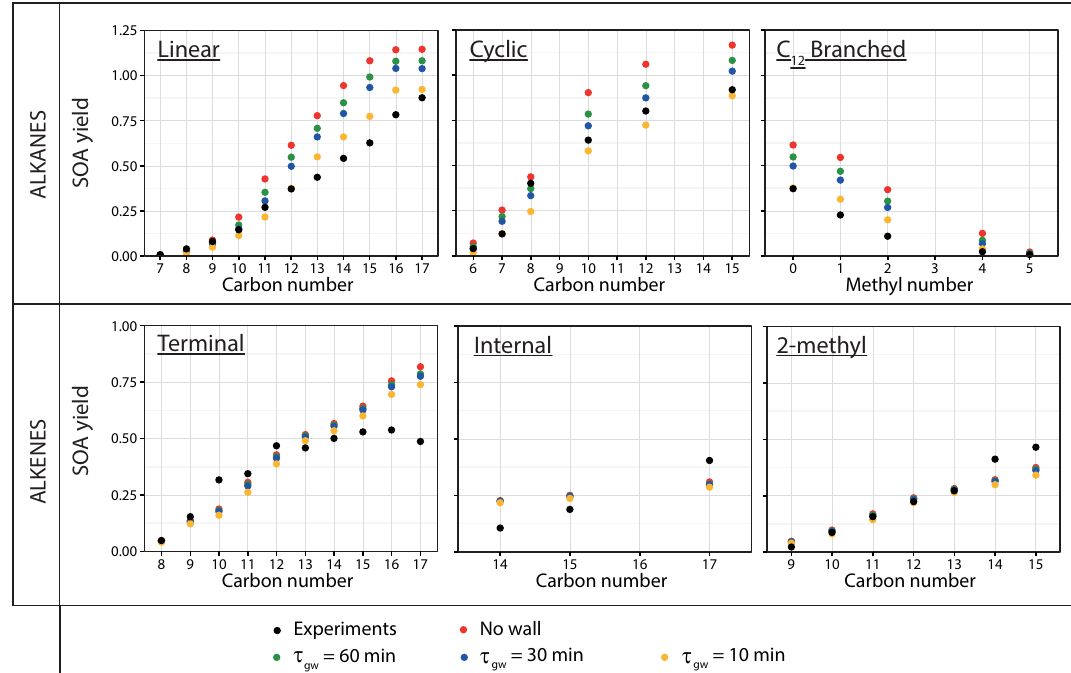
Figure 7. Comparison between measured (black) and simulated SOA yields for the different chemical families as a function of carbon chain length or presence of methyl groups on the carbon backbone. Simulations are shown without wall loss (red) and with wall loss using a value of C w /(M w γ w ) = 120µmolem − 3 for all secondary species and a τ gw of 10min (yellow), 30min (blue) or 60min